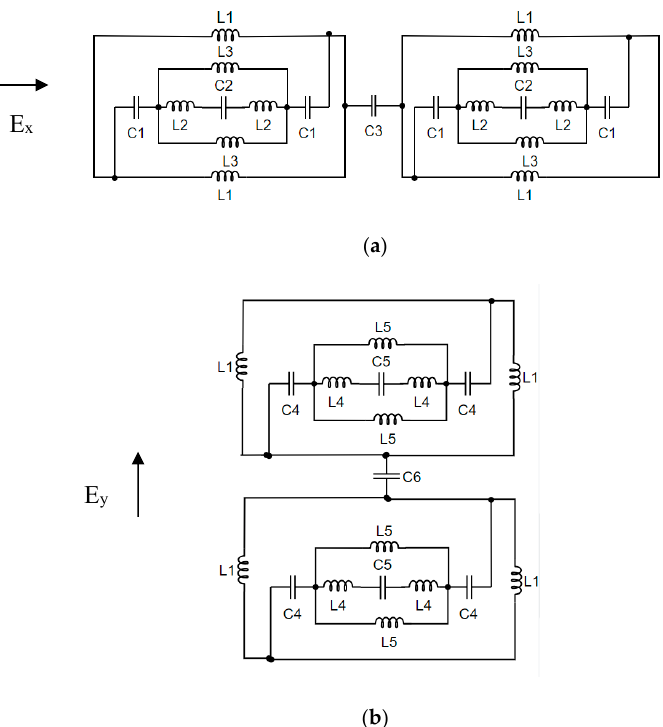
Figure 2. Equivalent circuit for the proposed converter under ( a ) X-polarization, ( b ) Y-polarization.